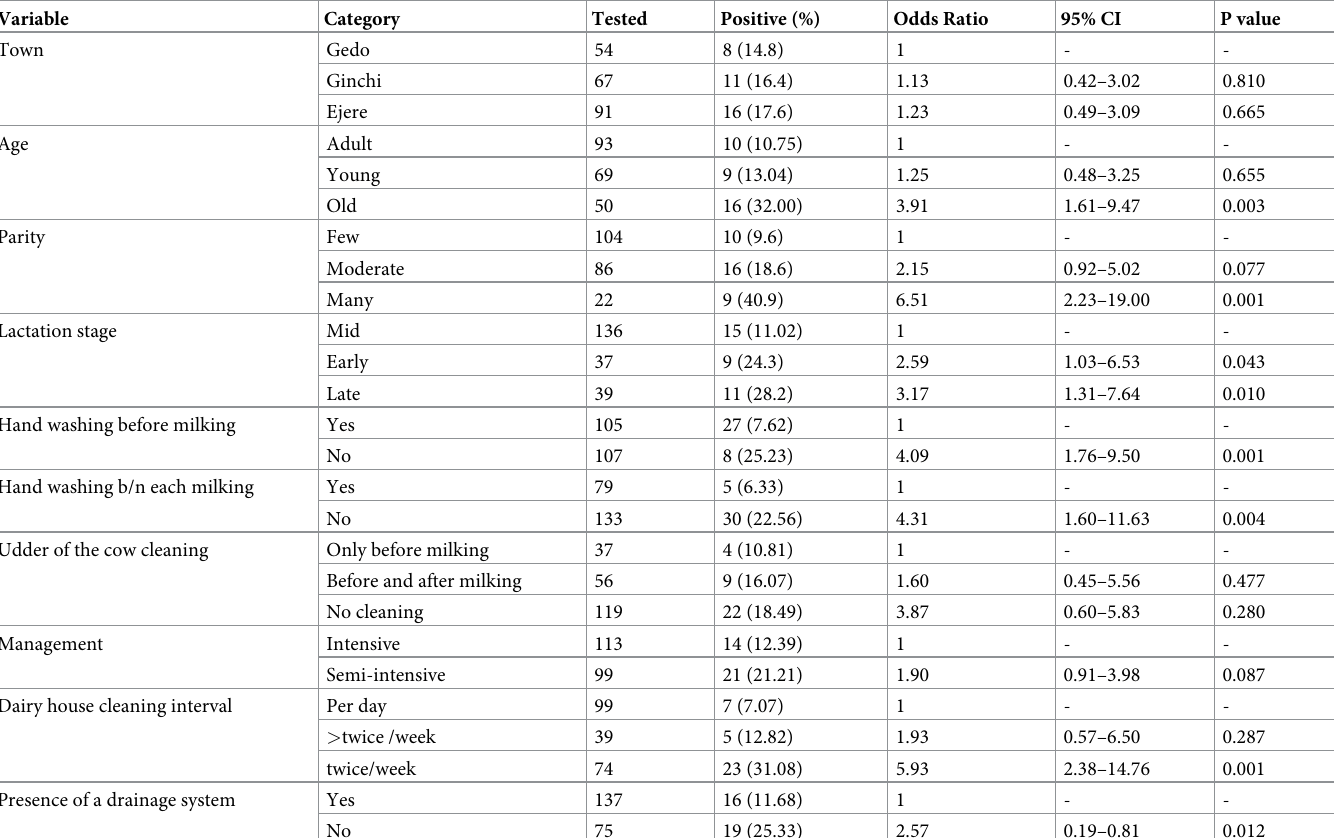
Table 5. The result of univariable logistic regression analysis of contributing risk factors for the occurrence and contamination of the milk with S . aureus in the study area.